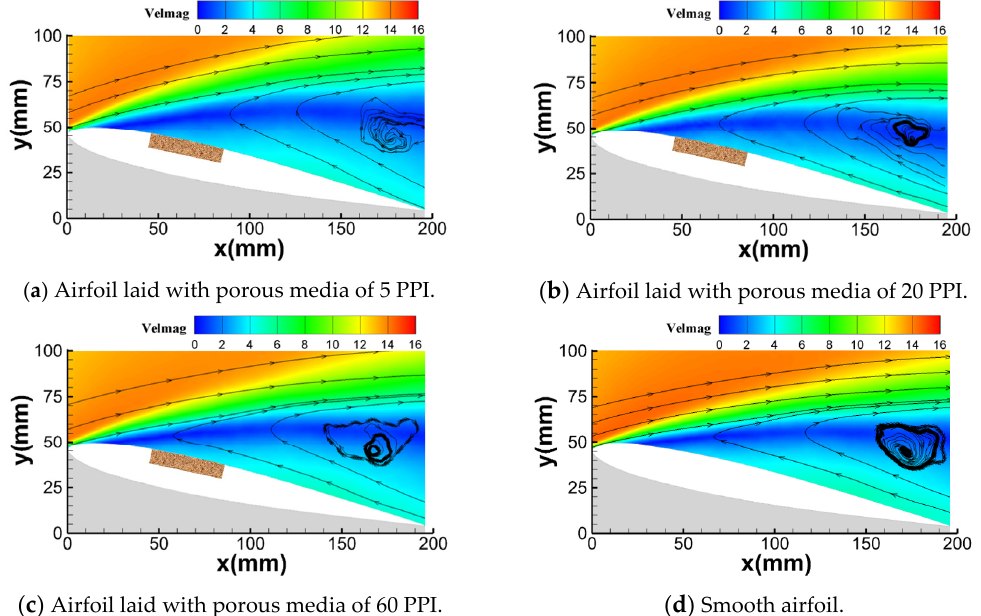
Figure 8. Time-averaged results of velocity field (AOA = 12).